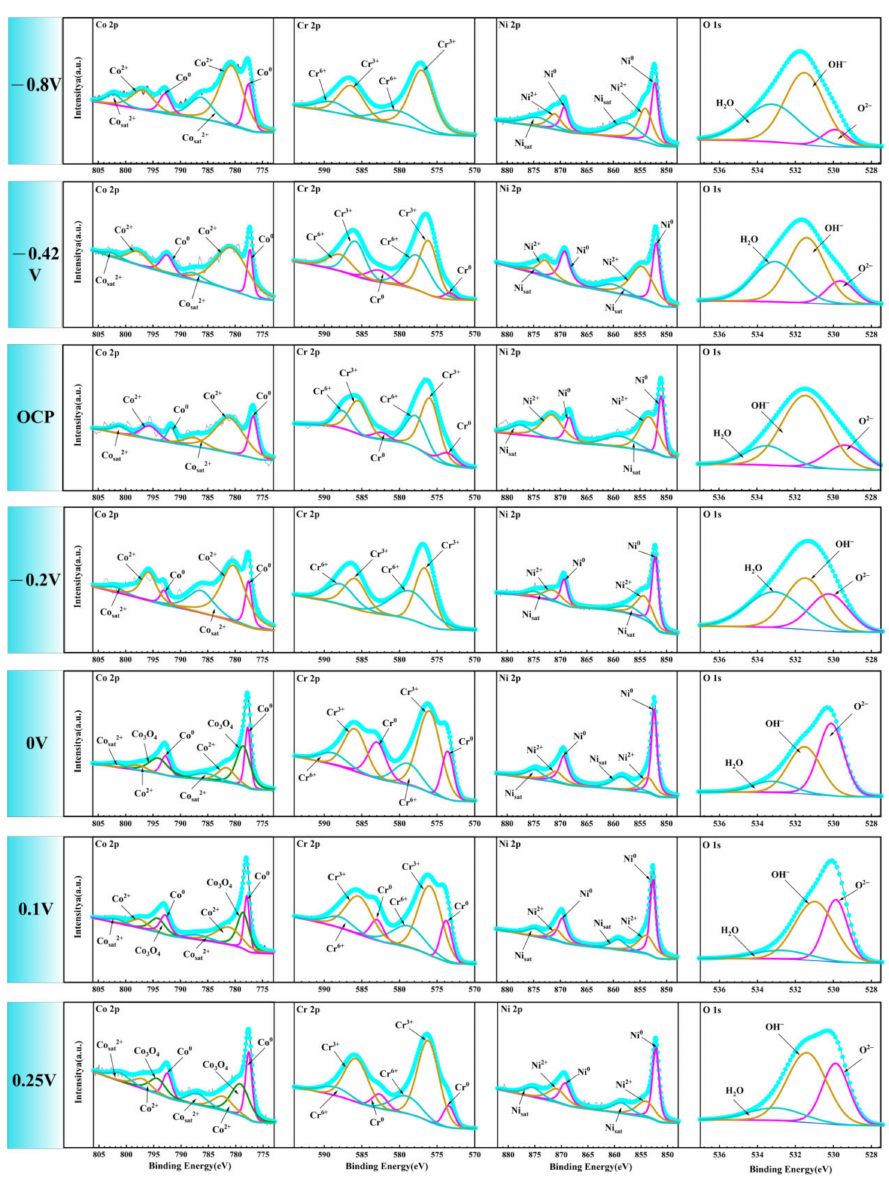
Figure 13. XPS spectrum of the worn surface of CoCrNi tested at different applied